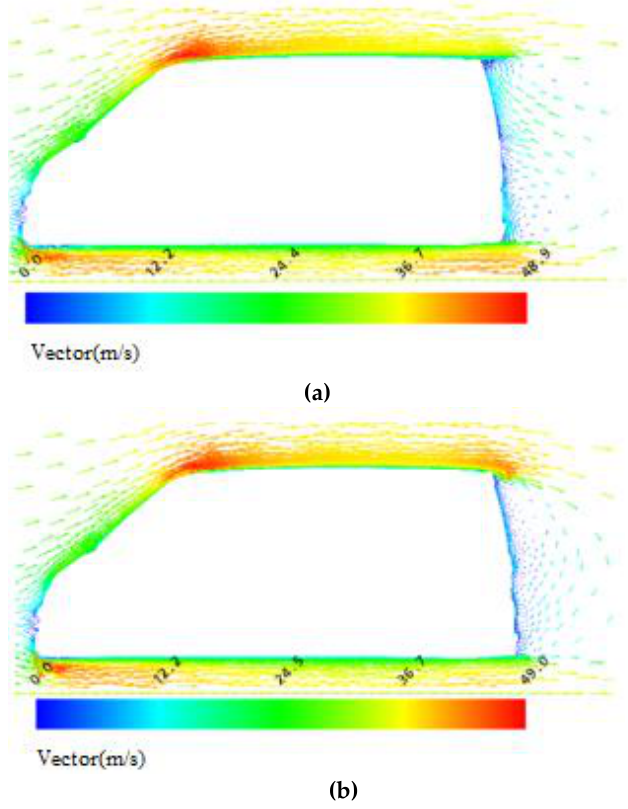
Figure 14. ( a ) Vector on the roof of the original minivan. ( b ) Vector on the roof of the optimized minivan.